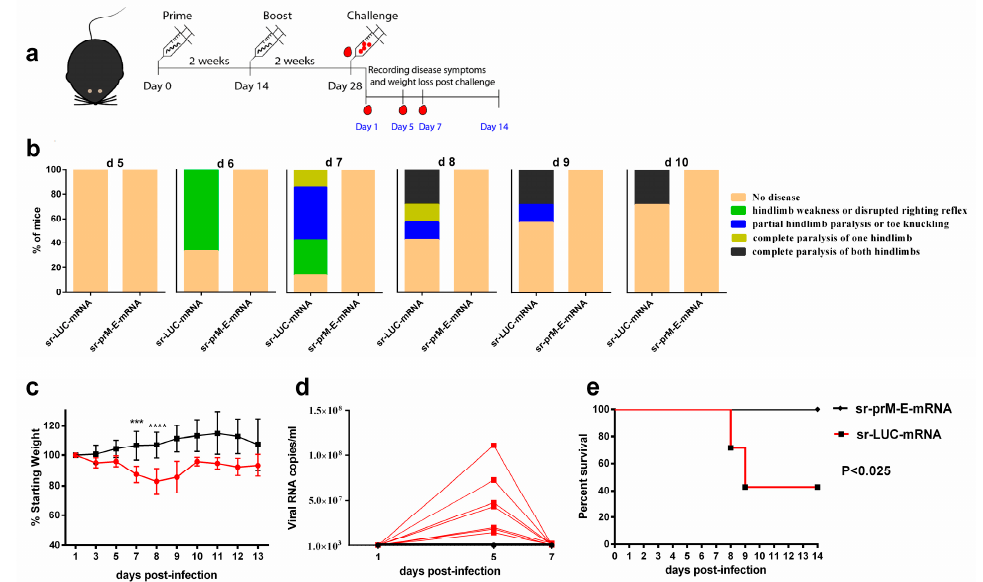
Figure 6. Protective efficacy of the sr-prM-E mRNA vaccine in IFNAR1 -/- mice. ( a ) Mice were intradermally electroporated on day 0 and 14 with 1 µg of sr-prM-E-mRNA ZIKV vaccine or sr-LUC-mRNA. Two weeks after the boost they were challenged by injecting 1000 TCID 50 of ZIKV (MR-766) in the footpad ( n = 7); ( b ) The disease symptoms were daily recorded from day 5 to day 10 after ZIKV challenge and ( c ) the percentage of weight loss relative to the body mass just before ZIKV infection was calculated; ( d ) the ZIKV RNA loads in plasma were determined by qRT-PCR. The dashed line indicates the limit of detection of the assay; ( e ) survival rates were determined based on the scoring system described in Table